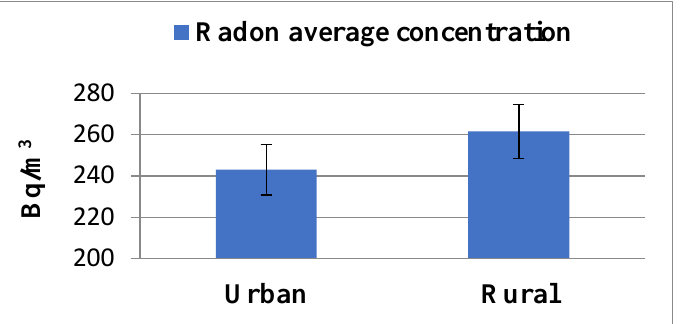
Figure 4. Concentration of radon in the air of homes, in rural and urban localities of the Republic of Moldova, year 2019 ( n = 2435 valid measurements with RADTRAK2 detectors, exposure period 90 days). The error bars indicate a 5% standard deviation of the data sets.